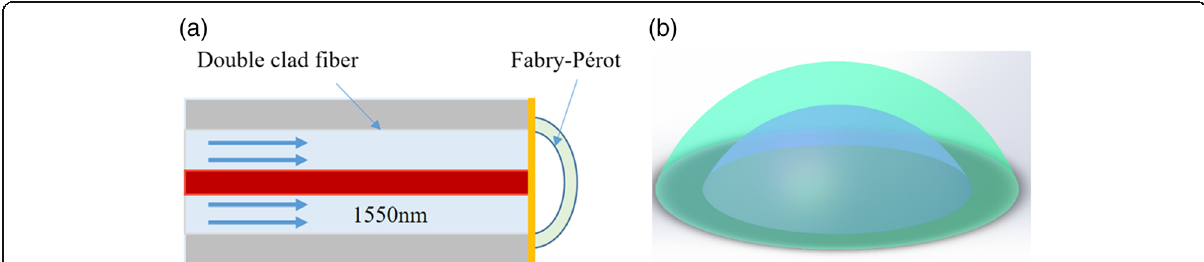
Fig. 1 ( a ) Schematic diagram of ultrasound detection based on the F – P cavity. The red area is the fiber core, the light blue area is the first inner cladding of the fiber, and the yellow area is the gold film formed by gold plating on the end face of the fiber. In addition, the arc part is the structure made of photoresist, and the F – P cavity is formed with the end face of the fiber. ( b ) Pattern layout of the F – P cavity using design software to create a model diagram corresponding to the arc-shaped part of ( a